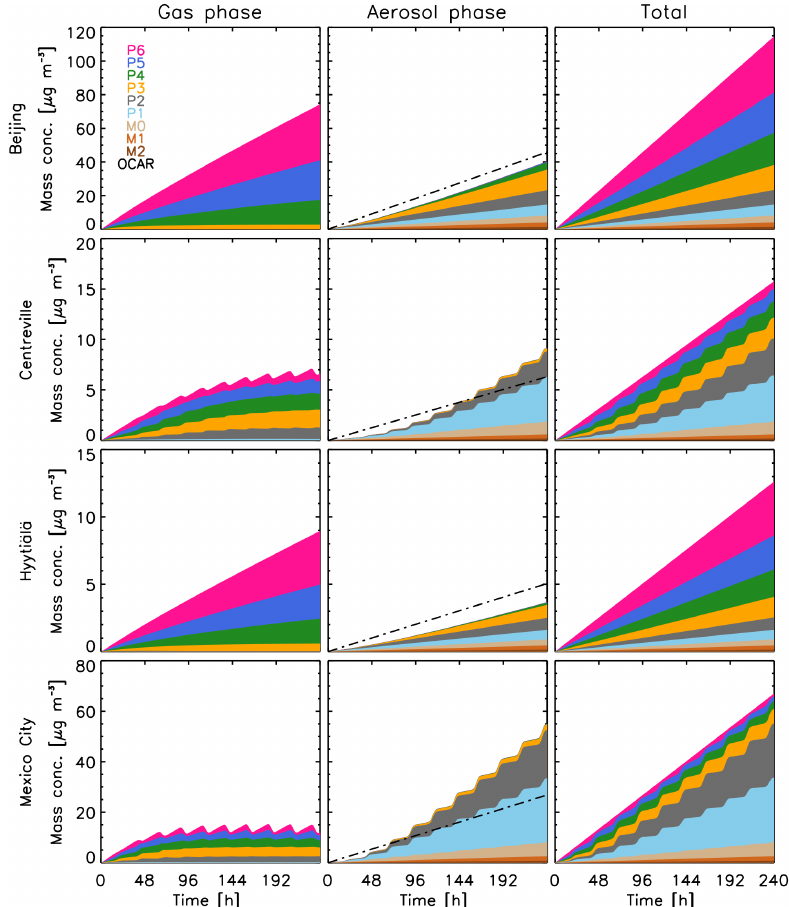
Figure 2. Temporal evolution of the mass concentration of semi-volatile organics in the gas phase (left column), aerosol phase (across all populations; middle column) and total (right column) using the new scheme (refer to Table 1 for legend) for January. The total of non-volatile organics from the original scheme (OCAR) is shown in black dash-dotted lines in the aerosol phase column (middle). OCAR from the old scheme is exactly 2.5 times smaller from the total organic species in the new